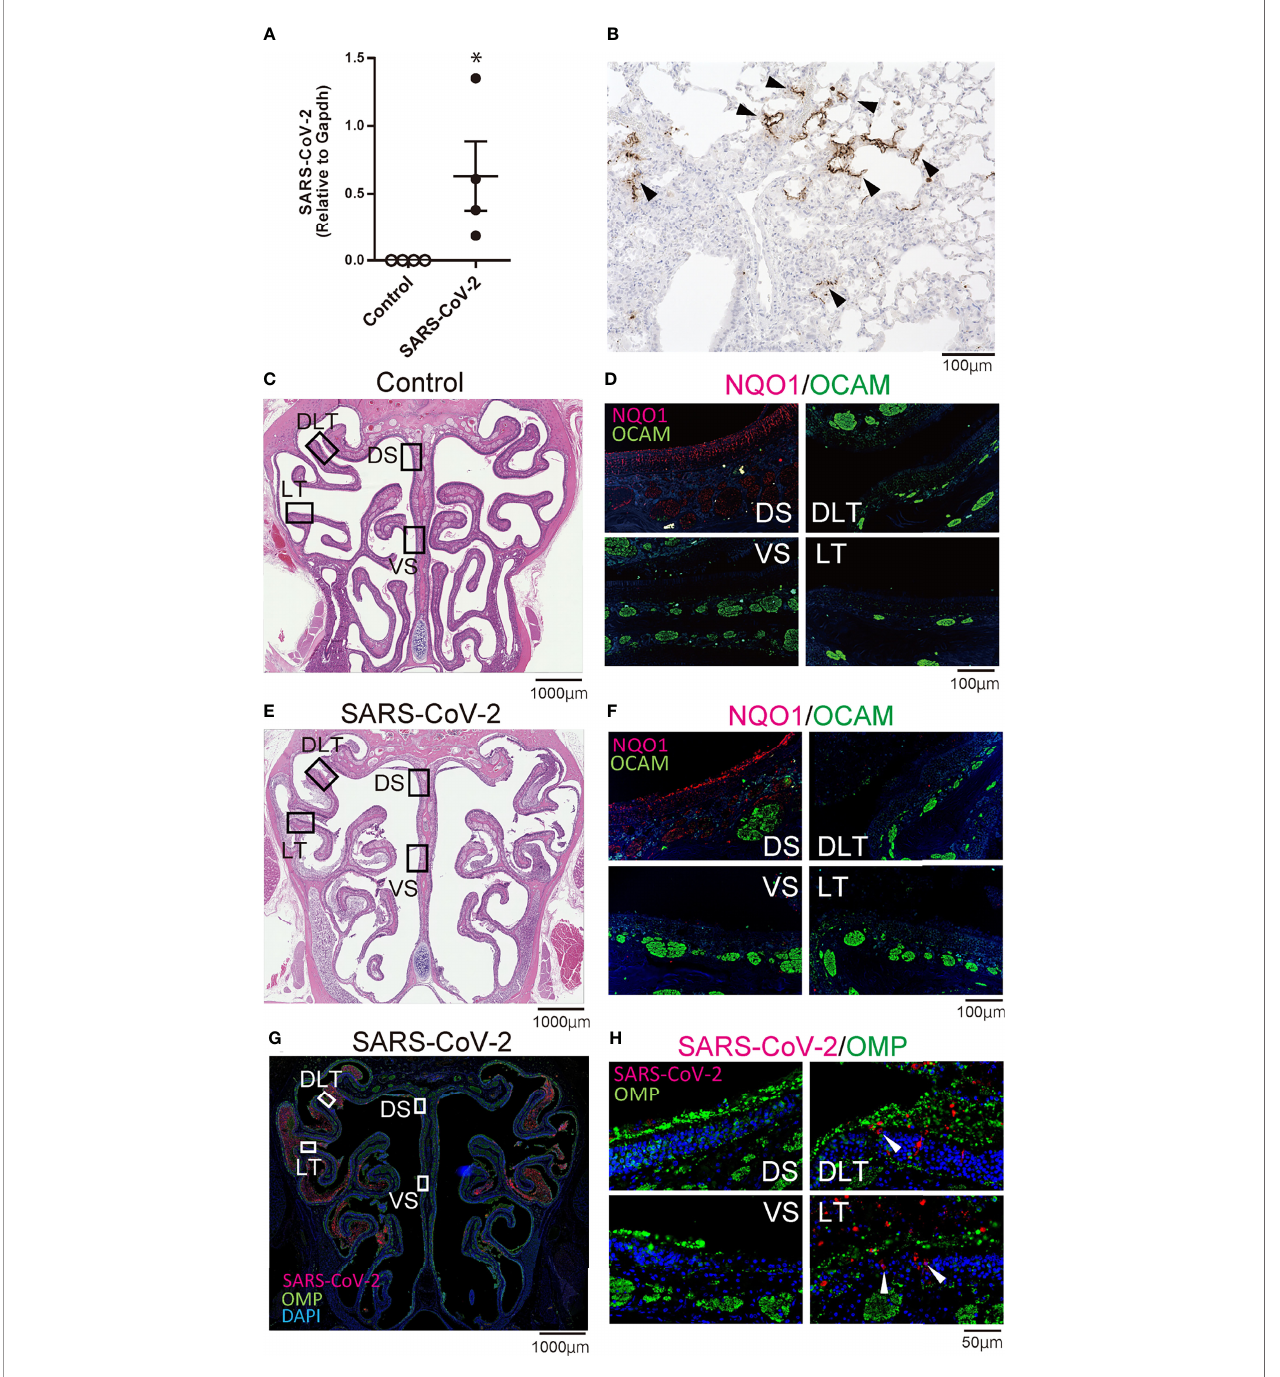
FIGURE 1 | Infectious fi ndings in the lungs and nasal cavity. (A) Severe acute respiratory syndrome coronavirus 2 (SARS-CoV-2) gene detection with RT- quantitative polymerase chain reaction (* P < 0.05). (B) Immunohistochemistry staining of SARS-CoV-2 in the lung (shown in brown, arrow heads). (C, D) Representative images of the olfactory epithelium from control hamsters (C: hematoxylin and eosin stain, D: immunohistological staining of NQO1 and OCAM). The boxes in (C) indicate the regions of the olfactory epithelium shown in D; the dorsal nasal septum (DS) area, ventral nasal septum (VS) area, dorsal lateral turbinate (DLT) area, and lateral turbinate (LT) area. Only the DS area appears positive for NQO1. (E, F) Representative images of the olfactory epithelium from SARS-CoV-2 hamsters. (G) Immunohistochemistry staining of the olfactory epithelium in SARS-CoV-2 hamsters. The virus is mainly present in the lateral region of the nasal cavity. (H) Double stained images of SARS-CoV-2 and OMP in each region of the olfactory epithelium. No double positive cells for SARS-CoV-2 and OMP are present in the olfactory epithelium. The arrow heads show SARS-CoV-2 positive